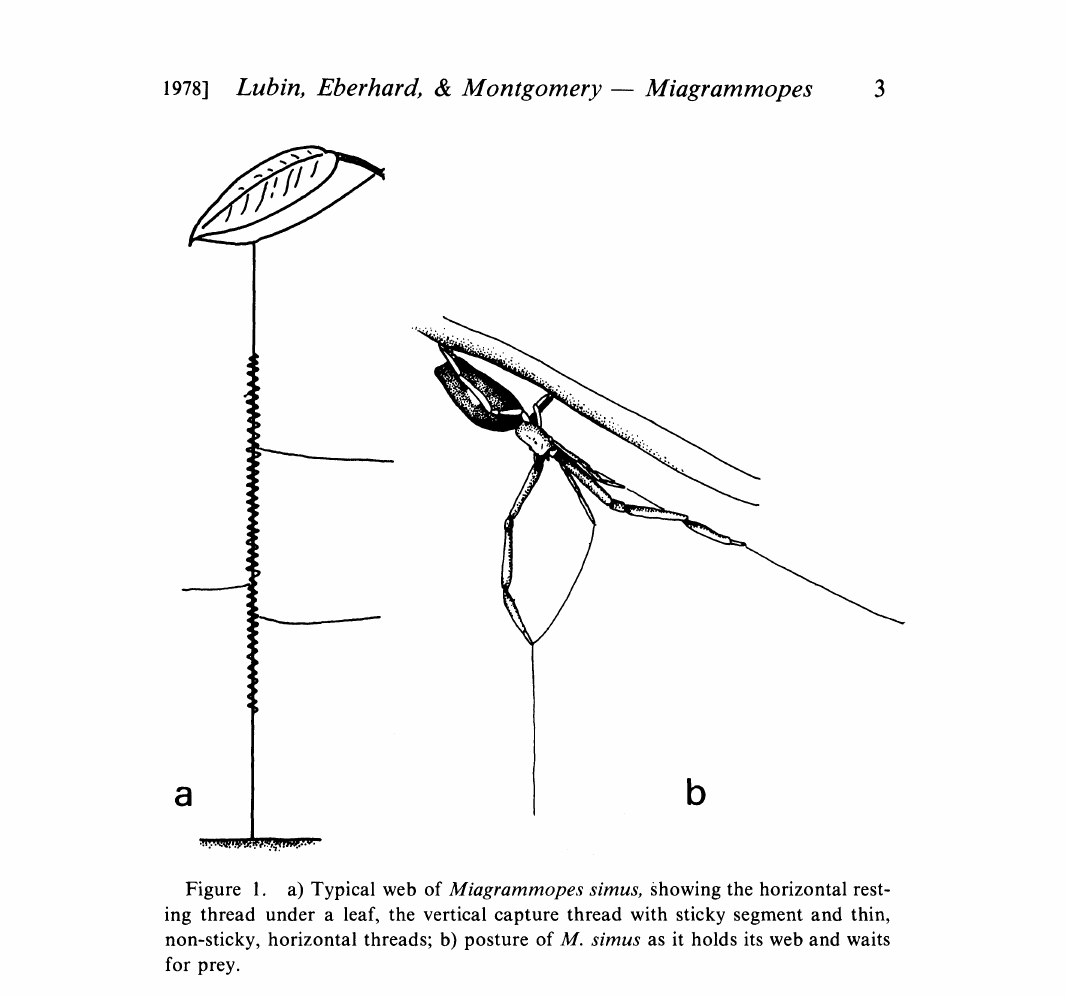
Figure 1. a) Typical web of Miagrammopes simus, Showing the horizontal rest- ing thread under a leaf, the vertical capture thread with sticky segment and thin, non-sticky, horizontal threads; b) posture of M. simus as it holds its web and waits for prey. capture threads rested in essentially the same position; the leg I holding the horizontal resting thread was in position to monitor vibrations from the second capture